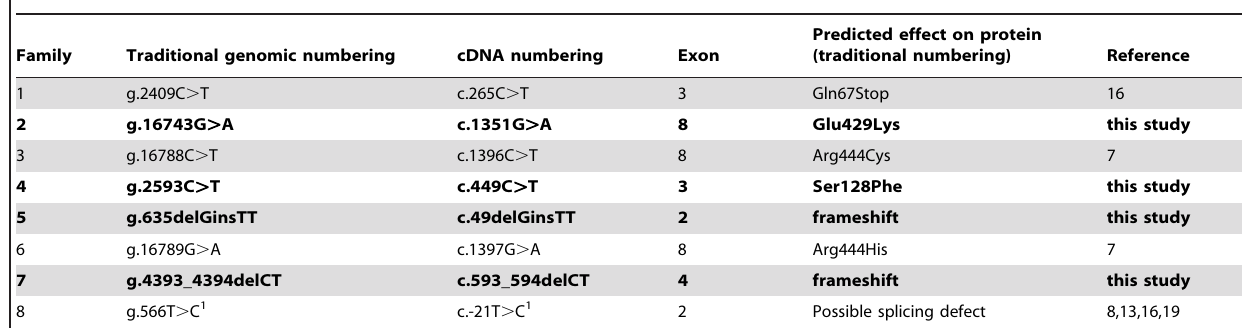
Table 2. Mutations found in Slovenian patients with